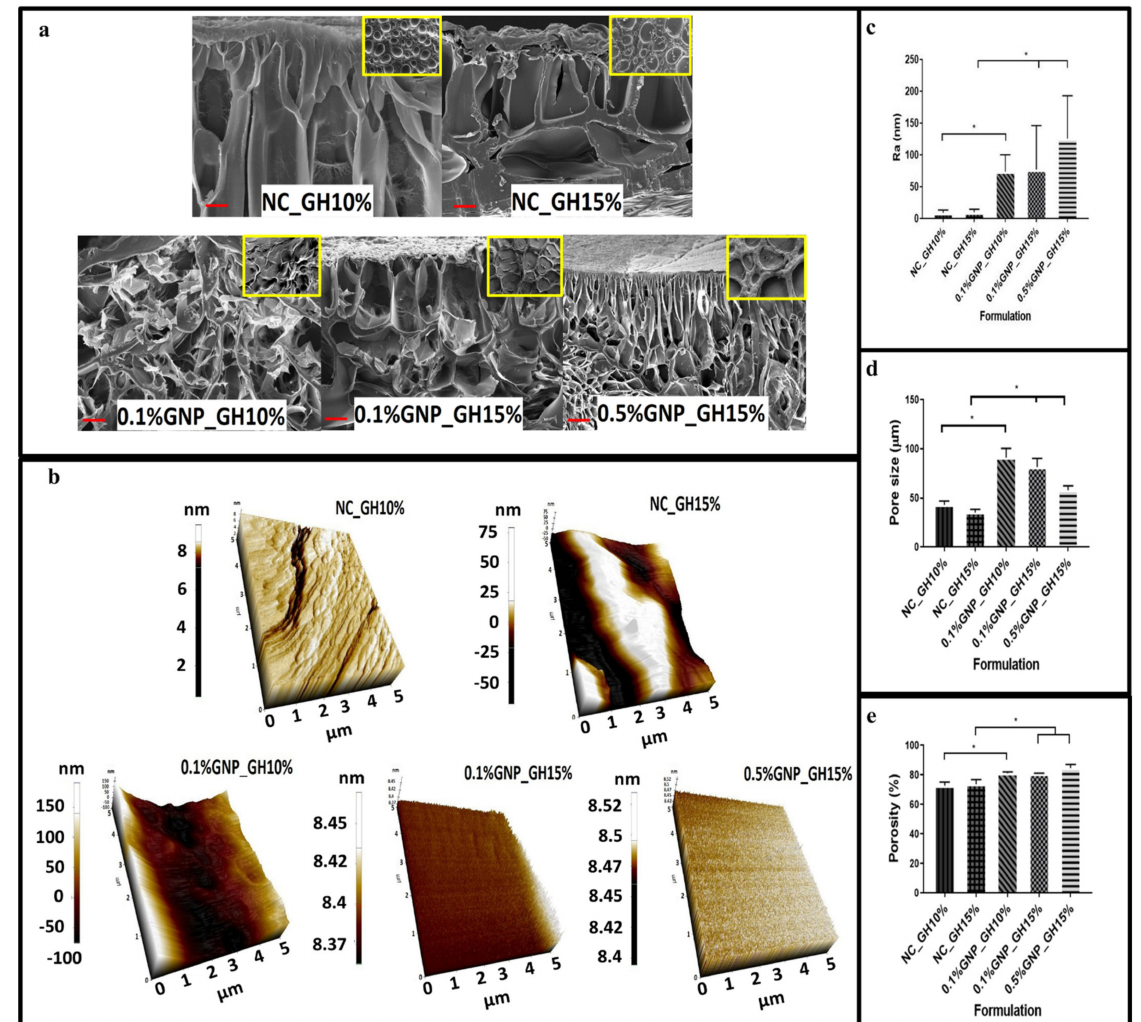
Figure 3. Porous structure, surface morphology and porosity ( a ) FESEM images revealed interconnected porous structures for both the cross section and surface of GNP_GH groups. ( b , c ) AFM analysis confirmed the roughness of GNP_GH. ( d ) Pore size of GNP_GH groups were within the range of 50–100 µ m. ( e ) Porosity of GNP_GH groups were >70% and significantly higher than NC_GH. * represented significant difference ( p < 0.05, n = 3, N = 3). Scale bar = 100 µ